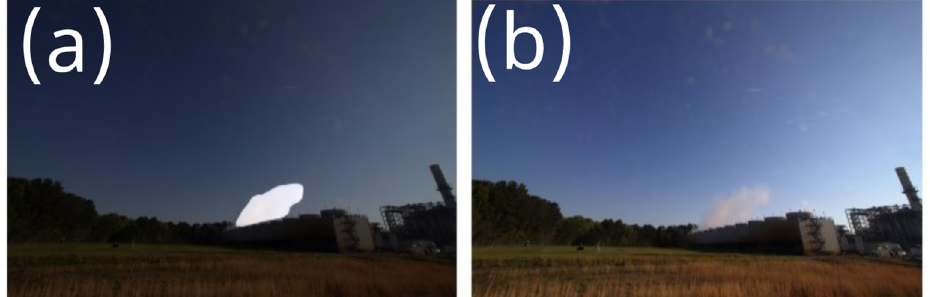
Figure 6. Plume identification in photos between ( a ) Mask R-CNN inference and ( b ) RGB image from one of the stationary cameras.